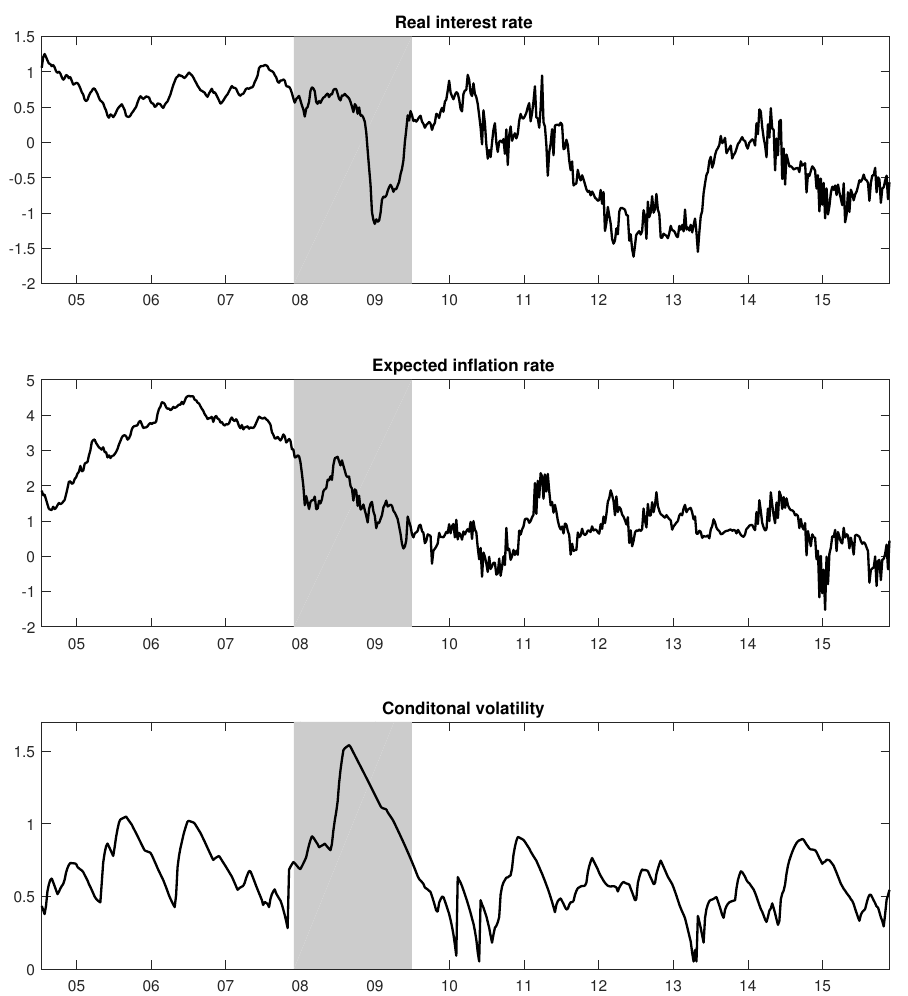
Figure 2. Evolution of the latent variables (annualized, in percentage) using CPI-U levels, nominal bond prices, inflation swap prices, and option implied volatilities. Real risk-free short rate R t , expected inflation rate µ t , and conditional variance h t are filtered using the UKF with CPI-U levels, nominal bond prices, and inflation swap prices from July 2004 to December 2015, as well as option implied volatilities from October 2009 to December 2015. Parameters of Table 4 are used. Values are annualized √ (i.e., R t and µ t is multiplied by 52; conditional volatility is 52 h t ). The grey-shaded region highlights the NBER-dated